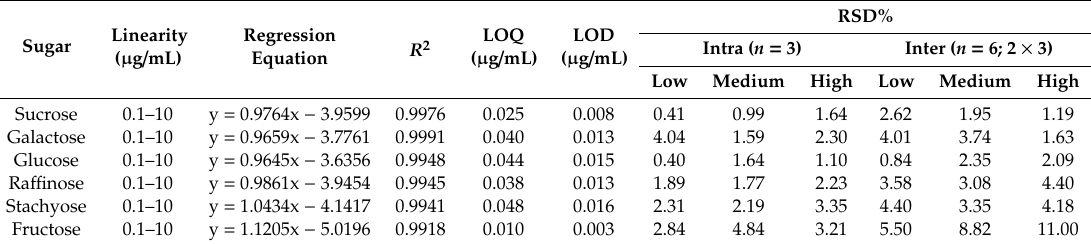
Figure 3. ( A ) Fatty acid methyl ester composition of the transesterified oil from 14 soybean cultivars and ( B ) principal component analyses of the fatty acid methyl ester composition data. All extractions and analyses were performed in triplicate and the error bar represents standard deviation between three or four replicate analyses. Table 2. Analytical method assessment for ionic chromatography of six sugars. LOQ, limit of quantitation; LOD, limit of detection.